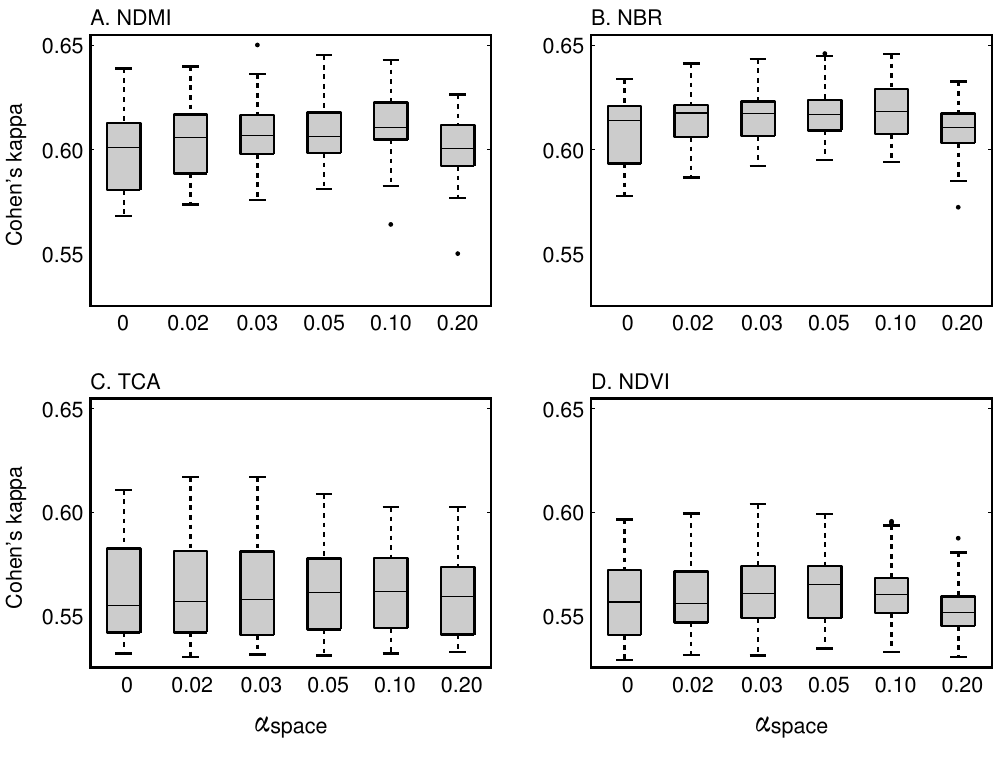
Figure 6. Effect of the strength of the spatial fidelity parameter on performance (kappa) within each vegetation index ( A – D ). Higher values of α space represent larger patches and less fidelity to the yearly composite images; zero represents no patch aggregation and complete fidelity to the composite